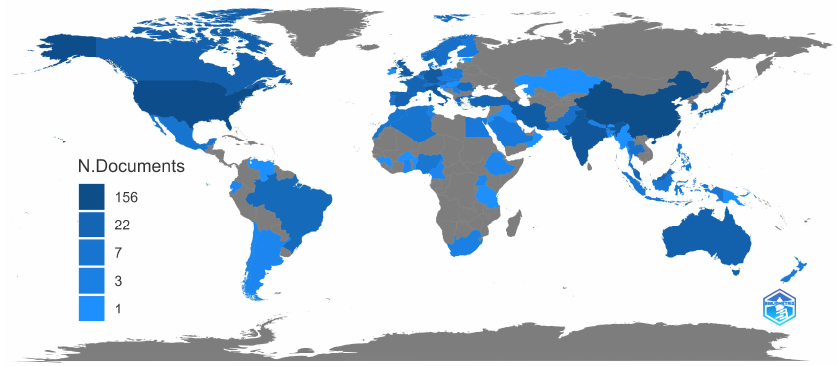
Figure 11. Spatial distribution of articles used for this research.